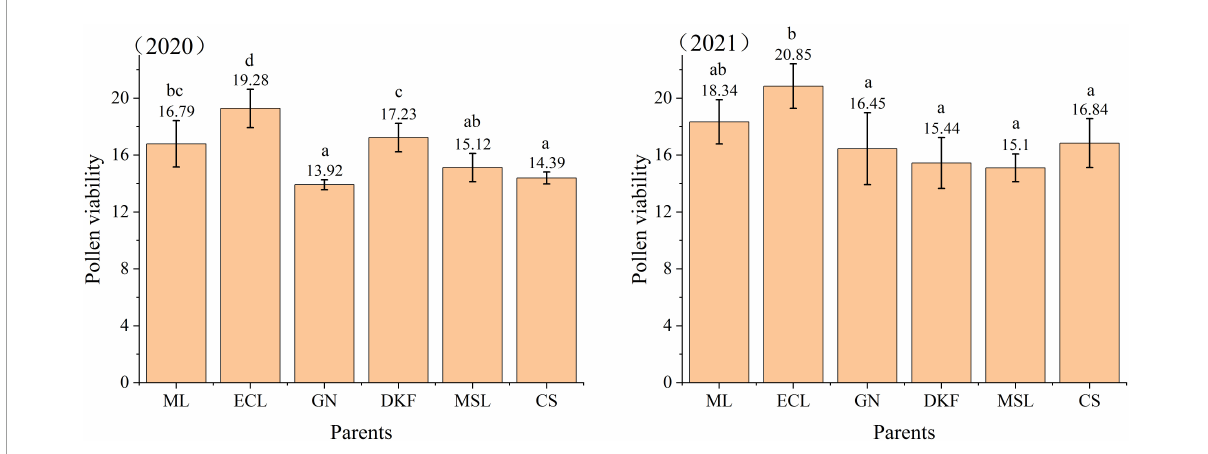
FIGURE1 Pollen viability of six tested cultivars by TTC staining in 2020–2021. The data in this figure were tested by one-way ANOVA with Tuker’s test ( P ≤ 0.05), and the same letter indicates that there is no significant difference in pollen viability among different parents. ML, ECL, GN, DKF, MSL, and CS represent cultivars of Meili, Ecolly, Garanior, Dunkelfelder, Marselan, and Cabernet